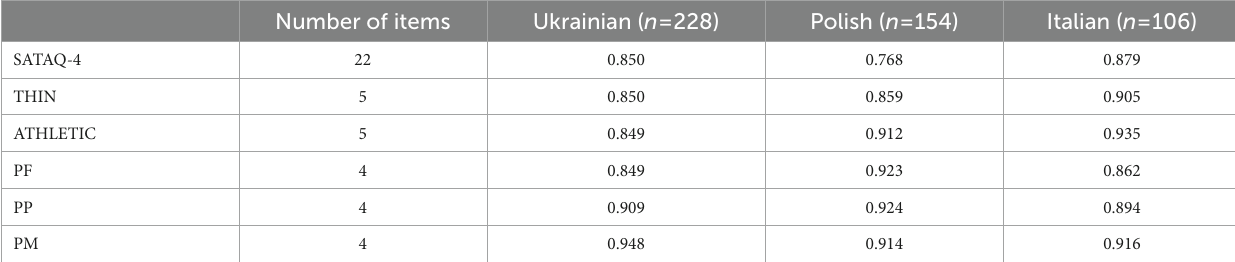
TABLE 2 Reliability (Cronbach’s alpha) analysis of the subscale and the entire SATAQ-4 questionnaire in the original version and in Polish adaptation in the group of Ukrainian, Polish, and Italian women. Number of items